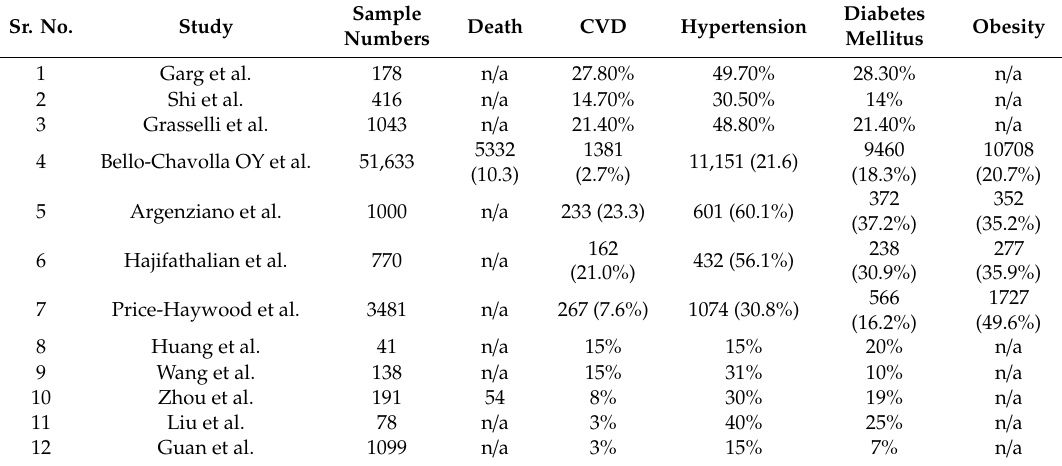
Table 1. Baseline characteristics of patients who tested positive for COVID-19 and compared with CVD, hypertension, diabetes, and obesity occurrence. Data are reported as absolute numbers and / or in percentages